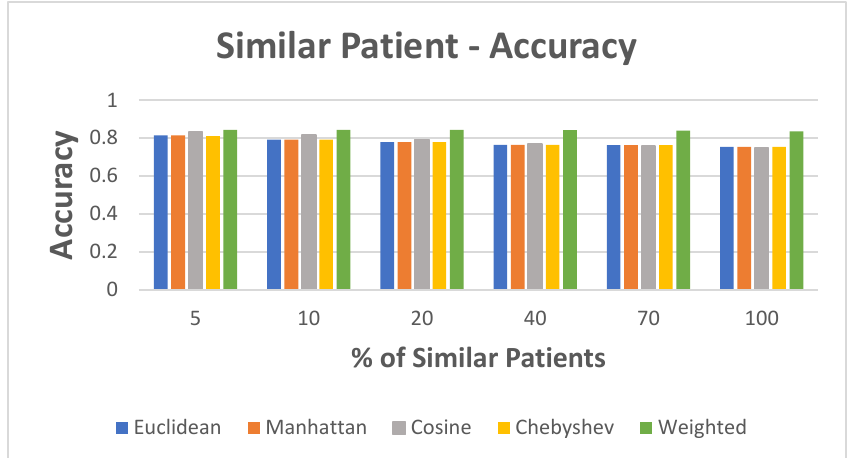
Figure 8. Static data: accuracy in the case of similar patients.